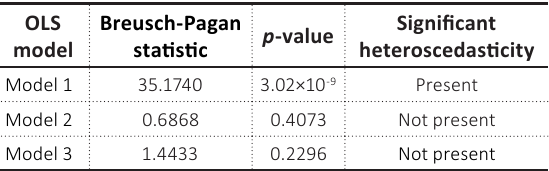
Table 2. Homoscedasticity test – Breusch-Pagan statistic